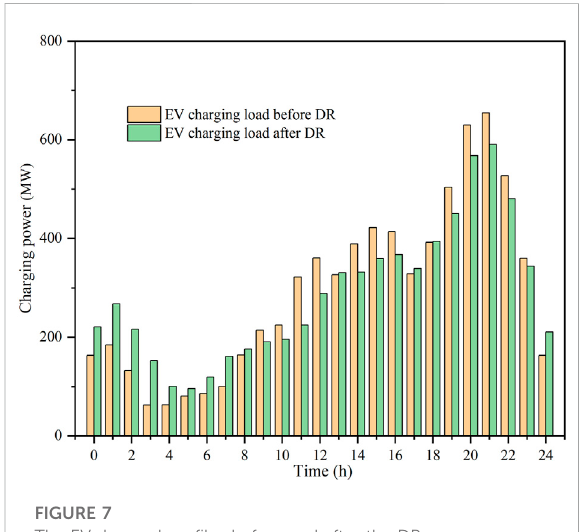
FIGURE 7 The EV demand pro fi les before and after the DR.